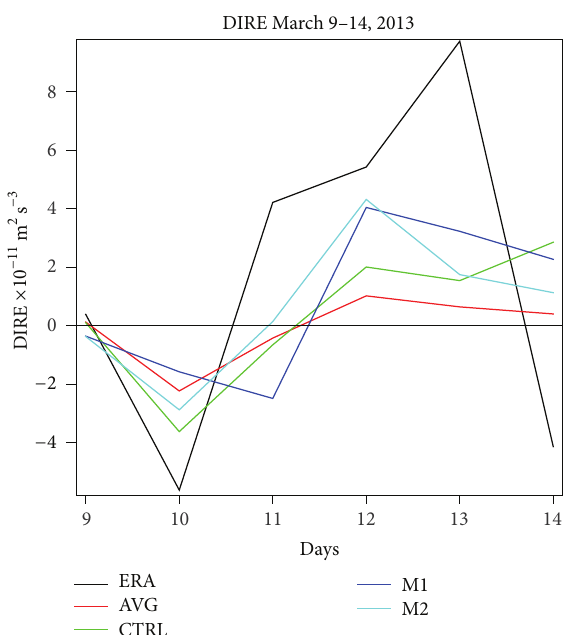
Figure 12: ERA and GEFS values of DIRE for March 9–14, 2013. Shown are ERA reanalysis (black), GEFS ensemble mean (red), GEFS control (green), and two other ensemble members (dark and light